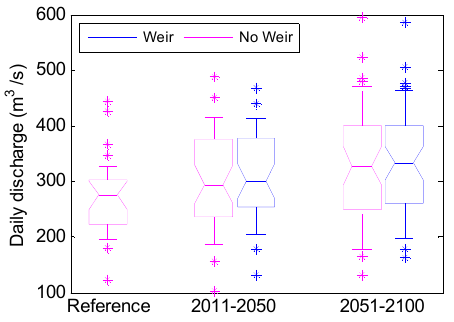
Figure 7. Simulated daily discharge at Gyuam site. Table 6. Simulation results for the Gyaum site, for various model conditions.